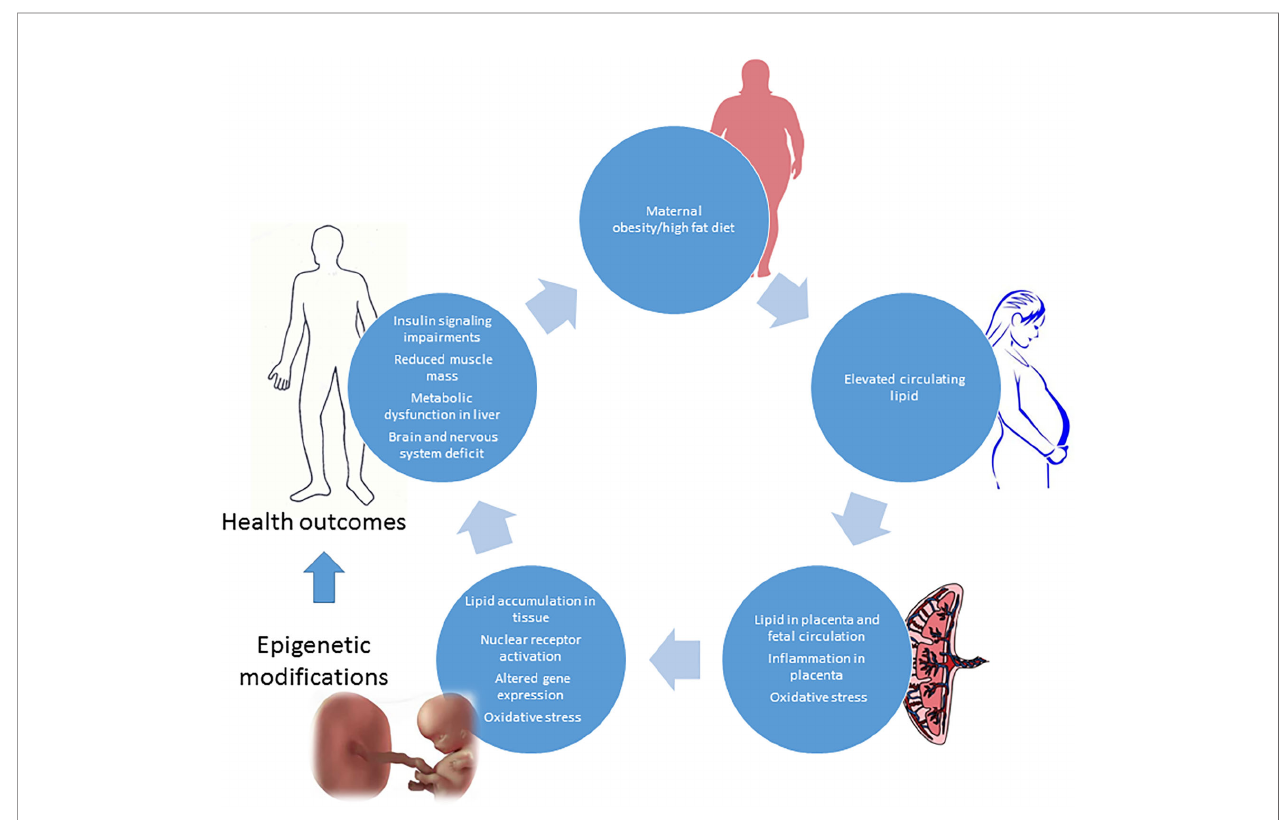
FIGURE 2 | Obesity and high fat diet in pregnancy: impact on fetus development and adverse health outcomes in adult later in